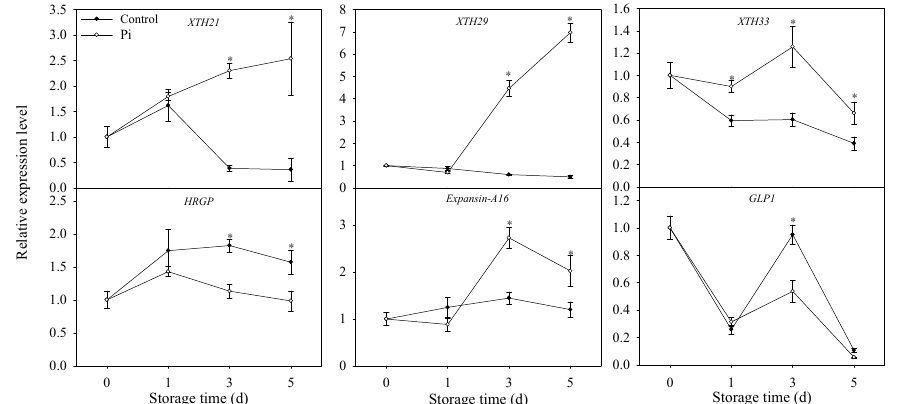
Figure 5. Effects of P. italicum infection on the expression levels of cell wall-related genes. Each data point represents a mean of three replicate assays ± standard error. Asterisks at the same storage time represented the significant differences ( P < 0.05). XTH: xyloglucan endotransglucosylase/hydrolase; HRGP: hydroxyproline-rich glycoprotein; GLP1: Germin-like protein 1.